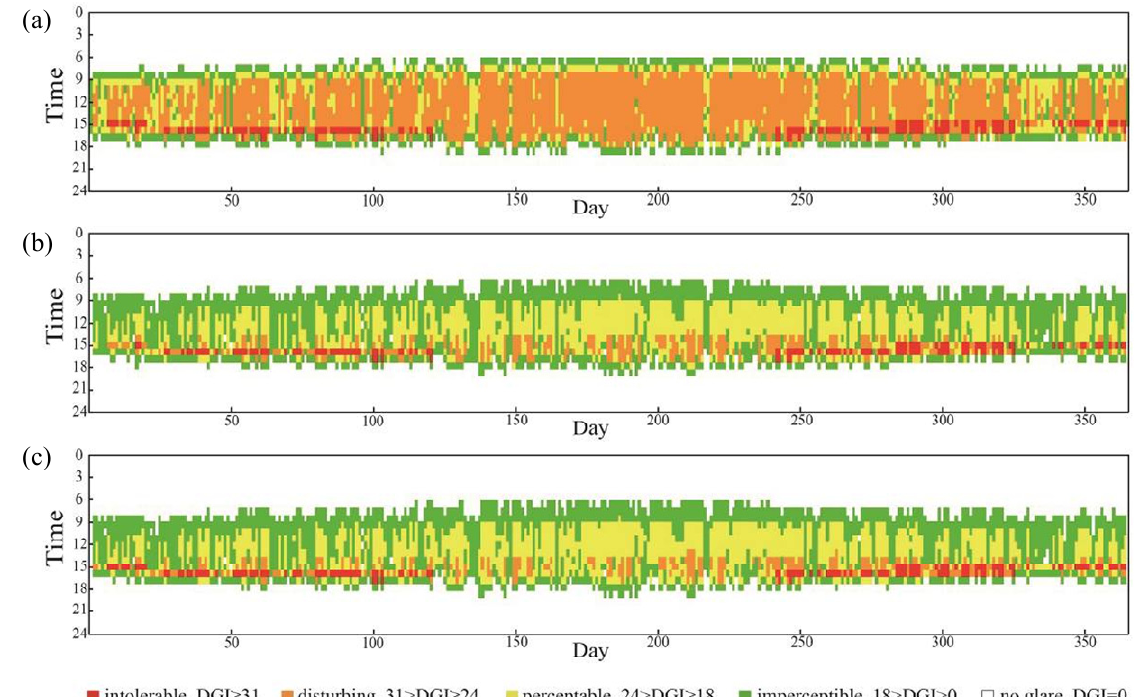
Figure 15. Temporal distribution map of DGI for the west facing case. ( a ) Without blind; ( b ) with fixed blind; ( c ) with the proposed